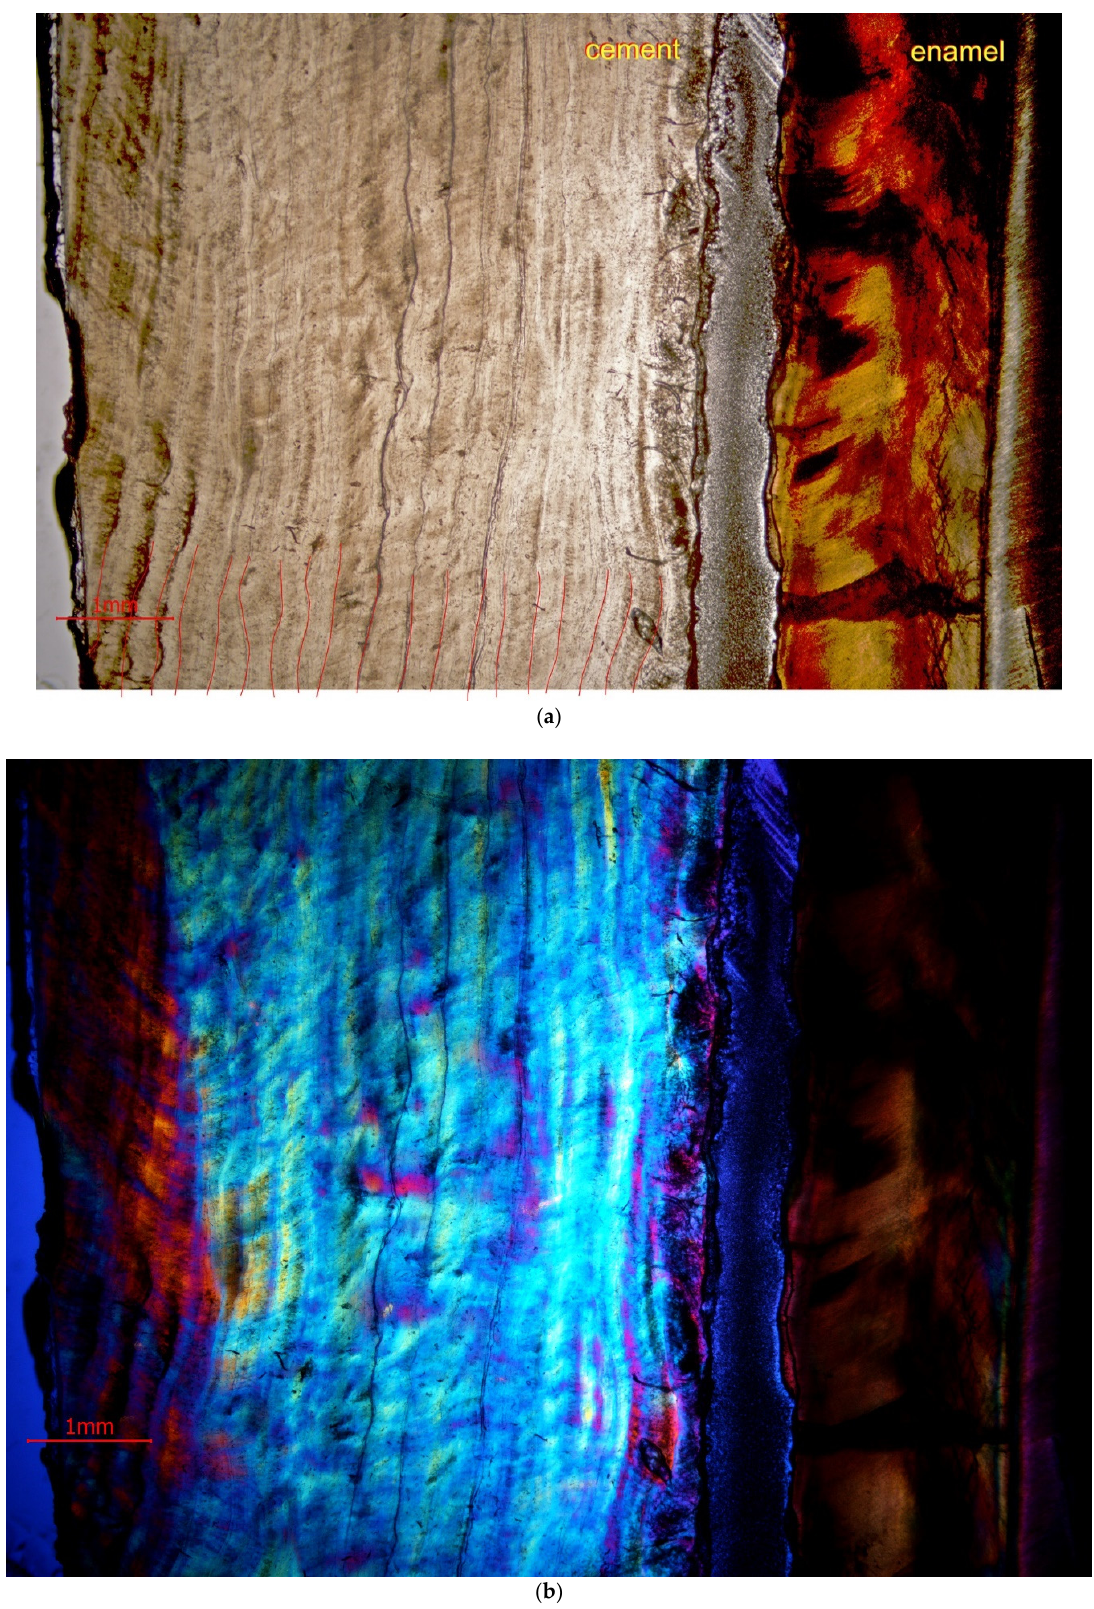
Figure 6. ( a ). Cement growth lines on the third premolar (P 3 ) of the white rhinoceros female. The part of the tooth analyzed here is indicated by a red arrow in Figure 8. ( b ). Cement lines on the third premolar (P 3 ) of the white rhinoceros female in polarized light. The part of the tooth analyzed here is indicated by a red arrow in Figure 8.